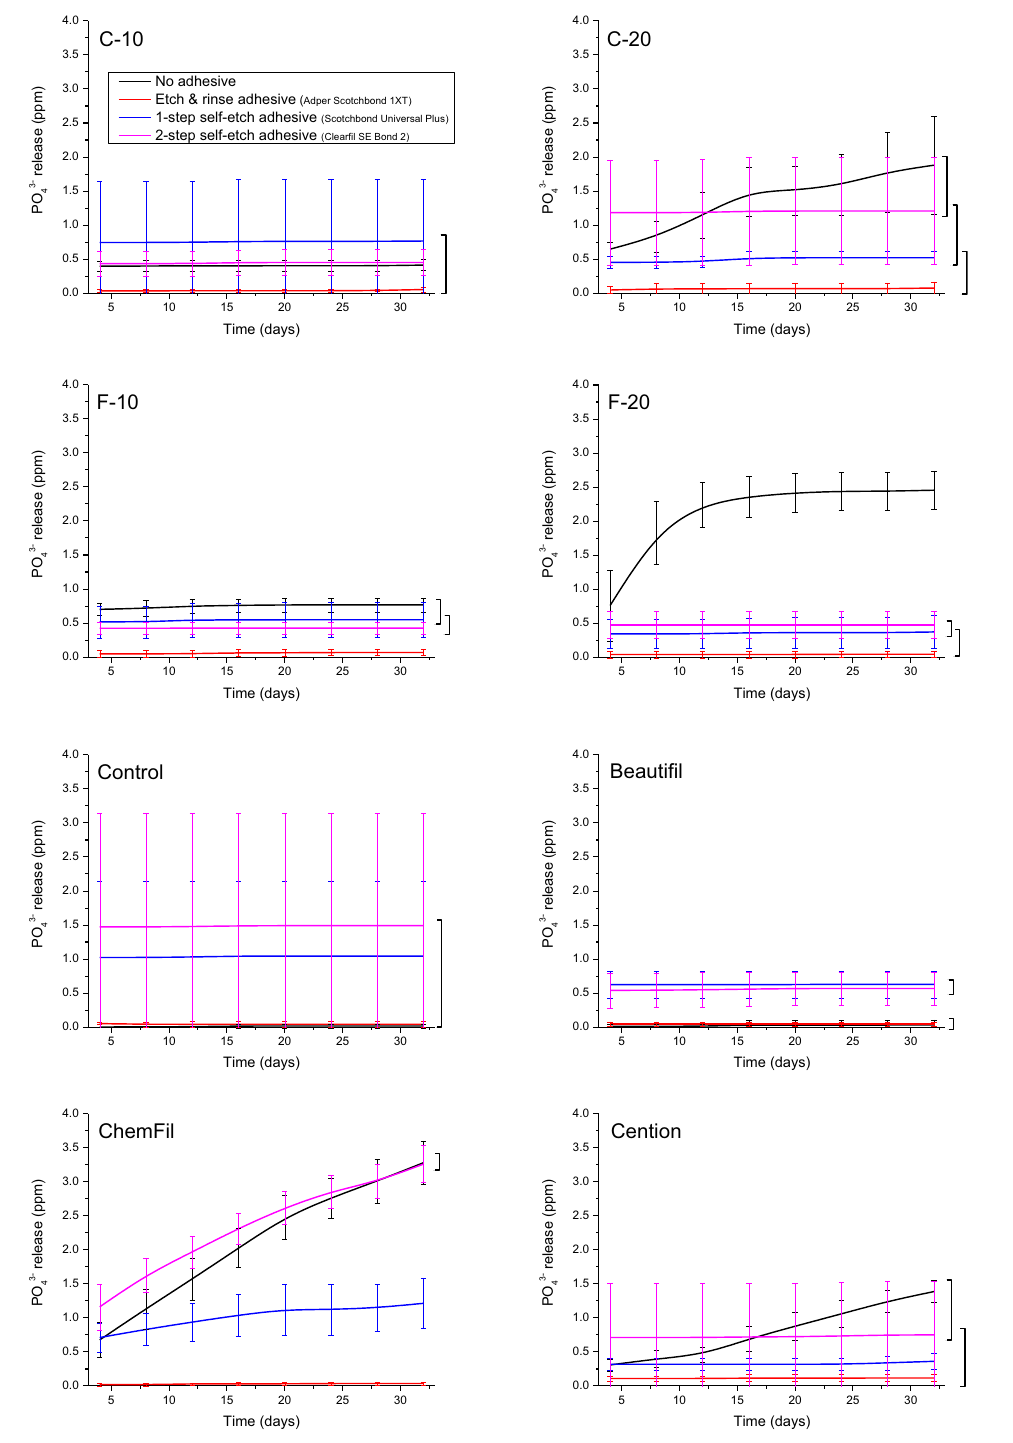
Figure 3. Cumulative concentrations of phosphate ions measured in lactic acid solution over 32 days. Square brackets indicate statistically similar values at the end of the observation